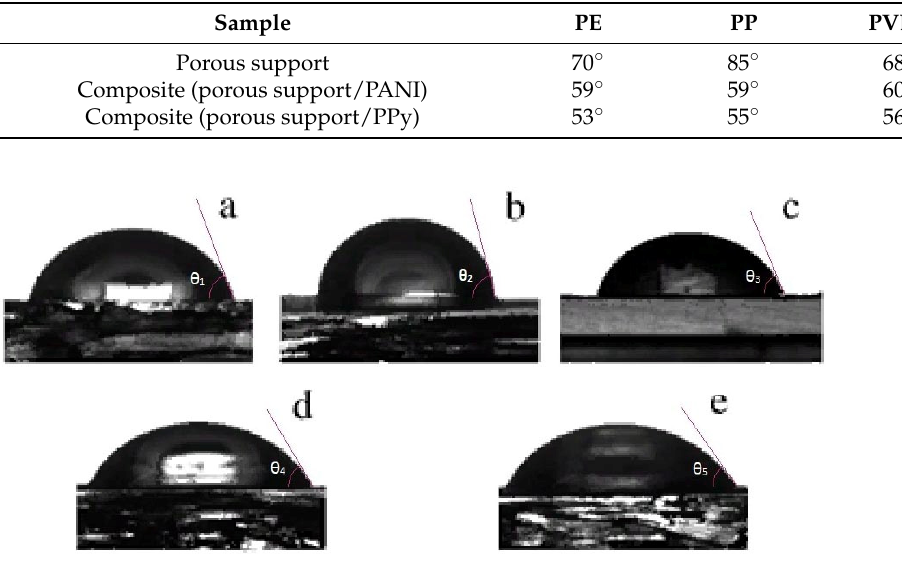
Table 4. Contact angle ( θ ) of the porous supports and the composites.